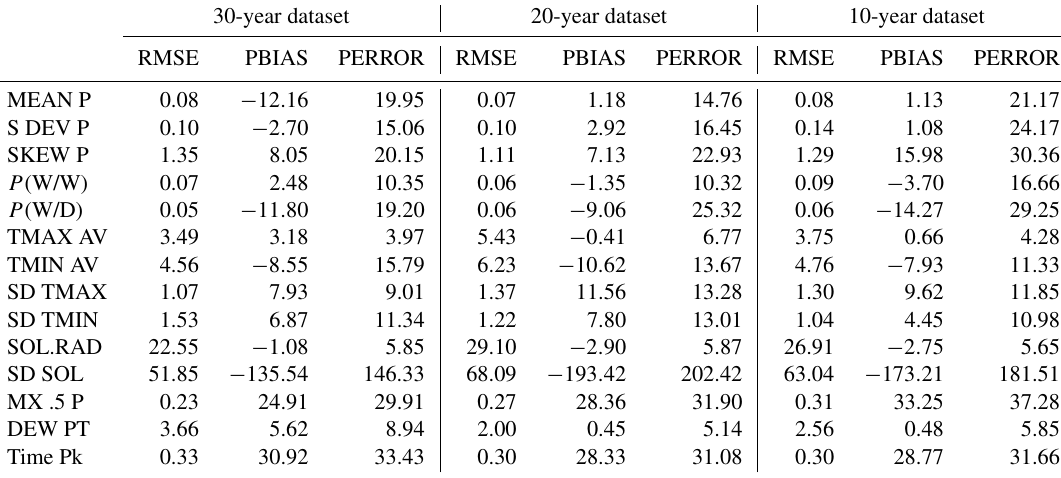
Table 4. Summary of the validation of parameters to the 2015 US CLIGEN dataset created by Srivastava et al.